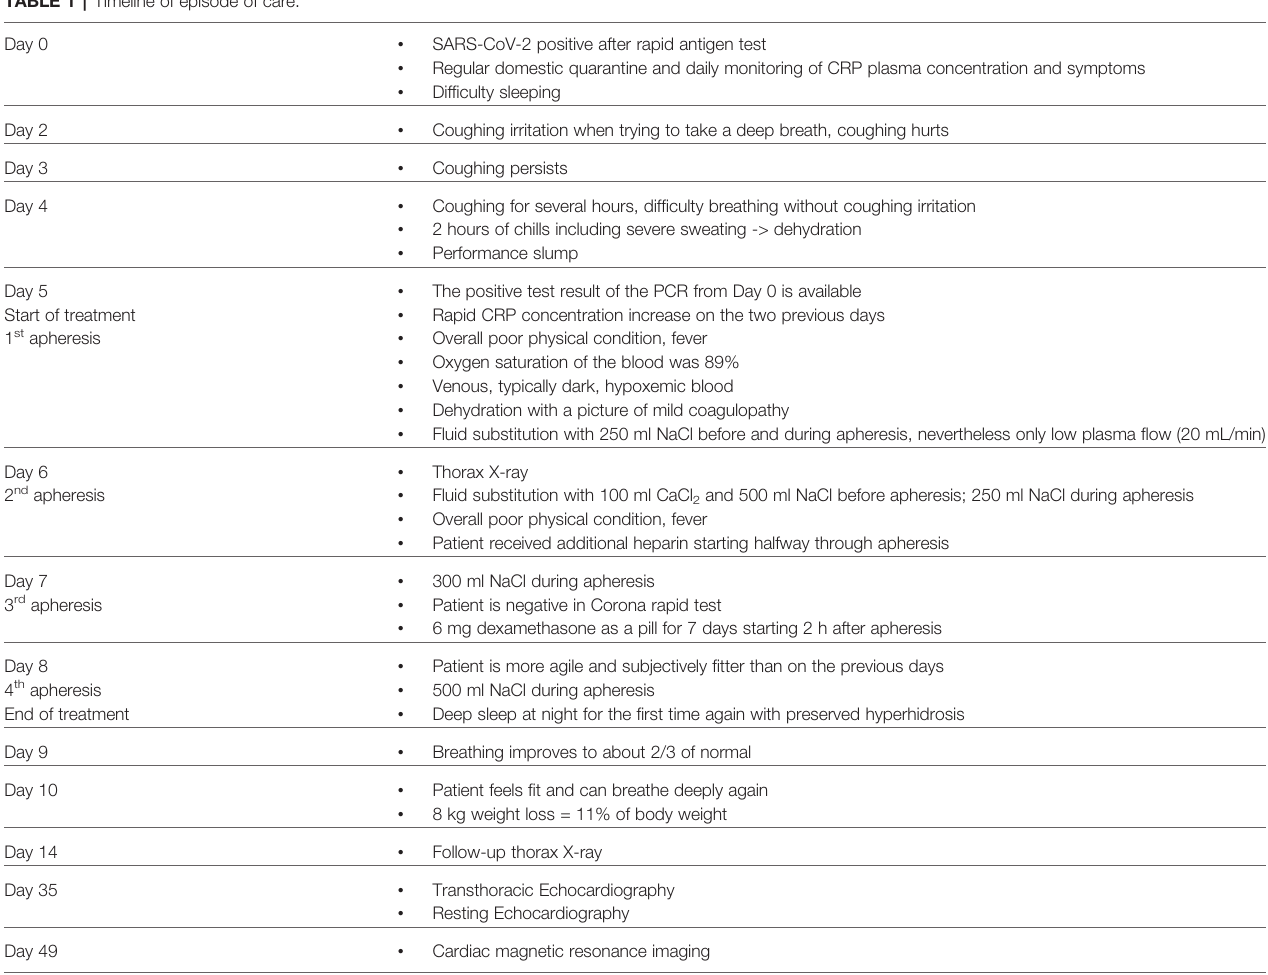
TABLE 1 | Timeline of episode of care.